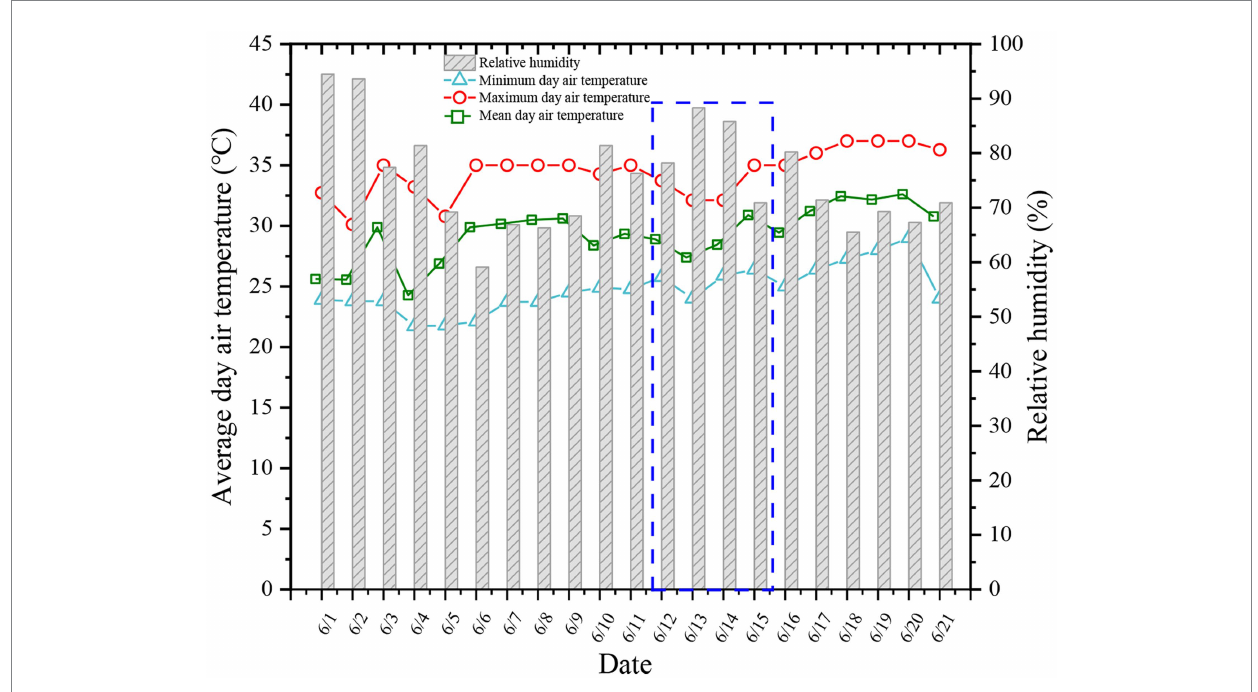
FIGURE 2 Distribution of temperature and humidity in Guangzhou in June 2021.